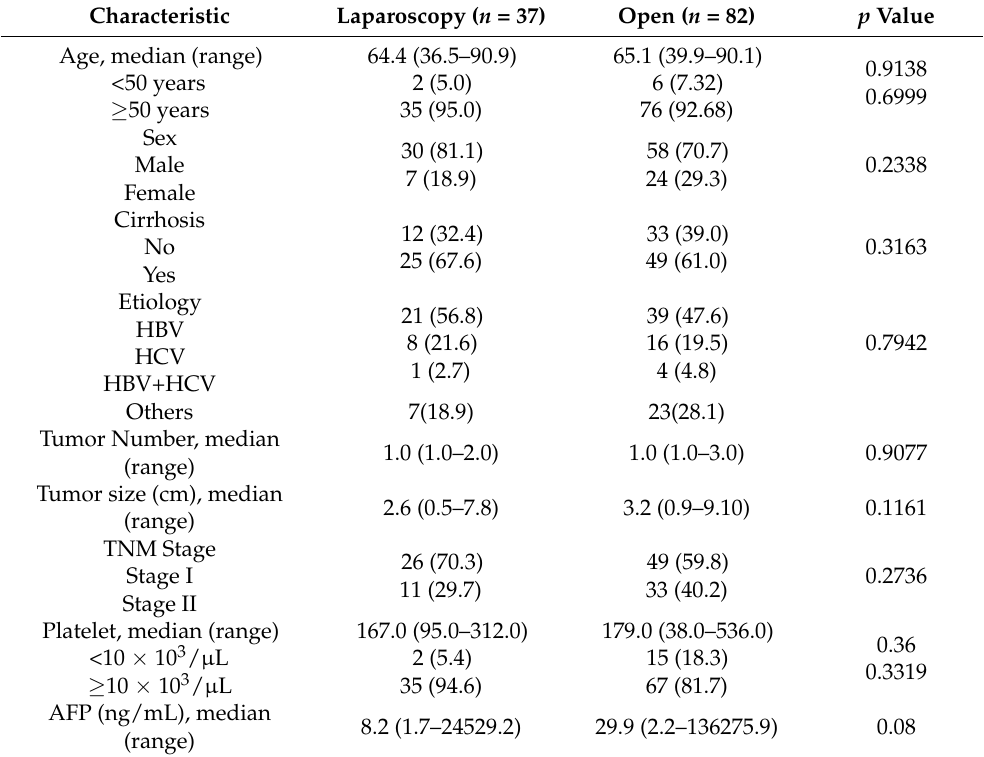
Figure 3. Cumulative recurrent rates of patients according to tumor size and treatment modalities. The cumulative incidence of HCC recurrence was significantly higher for patients who underwent radiofrequency ablation (RFA) in both tumor size ≥ 2 cm and <2 cm as compared with that of liver resection (LR). Table 3. Comparison of clinical characteristics according to liver resection approach for patients with